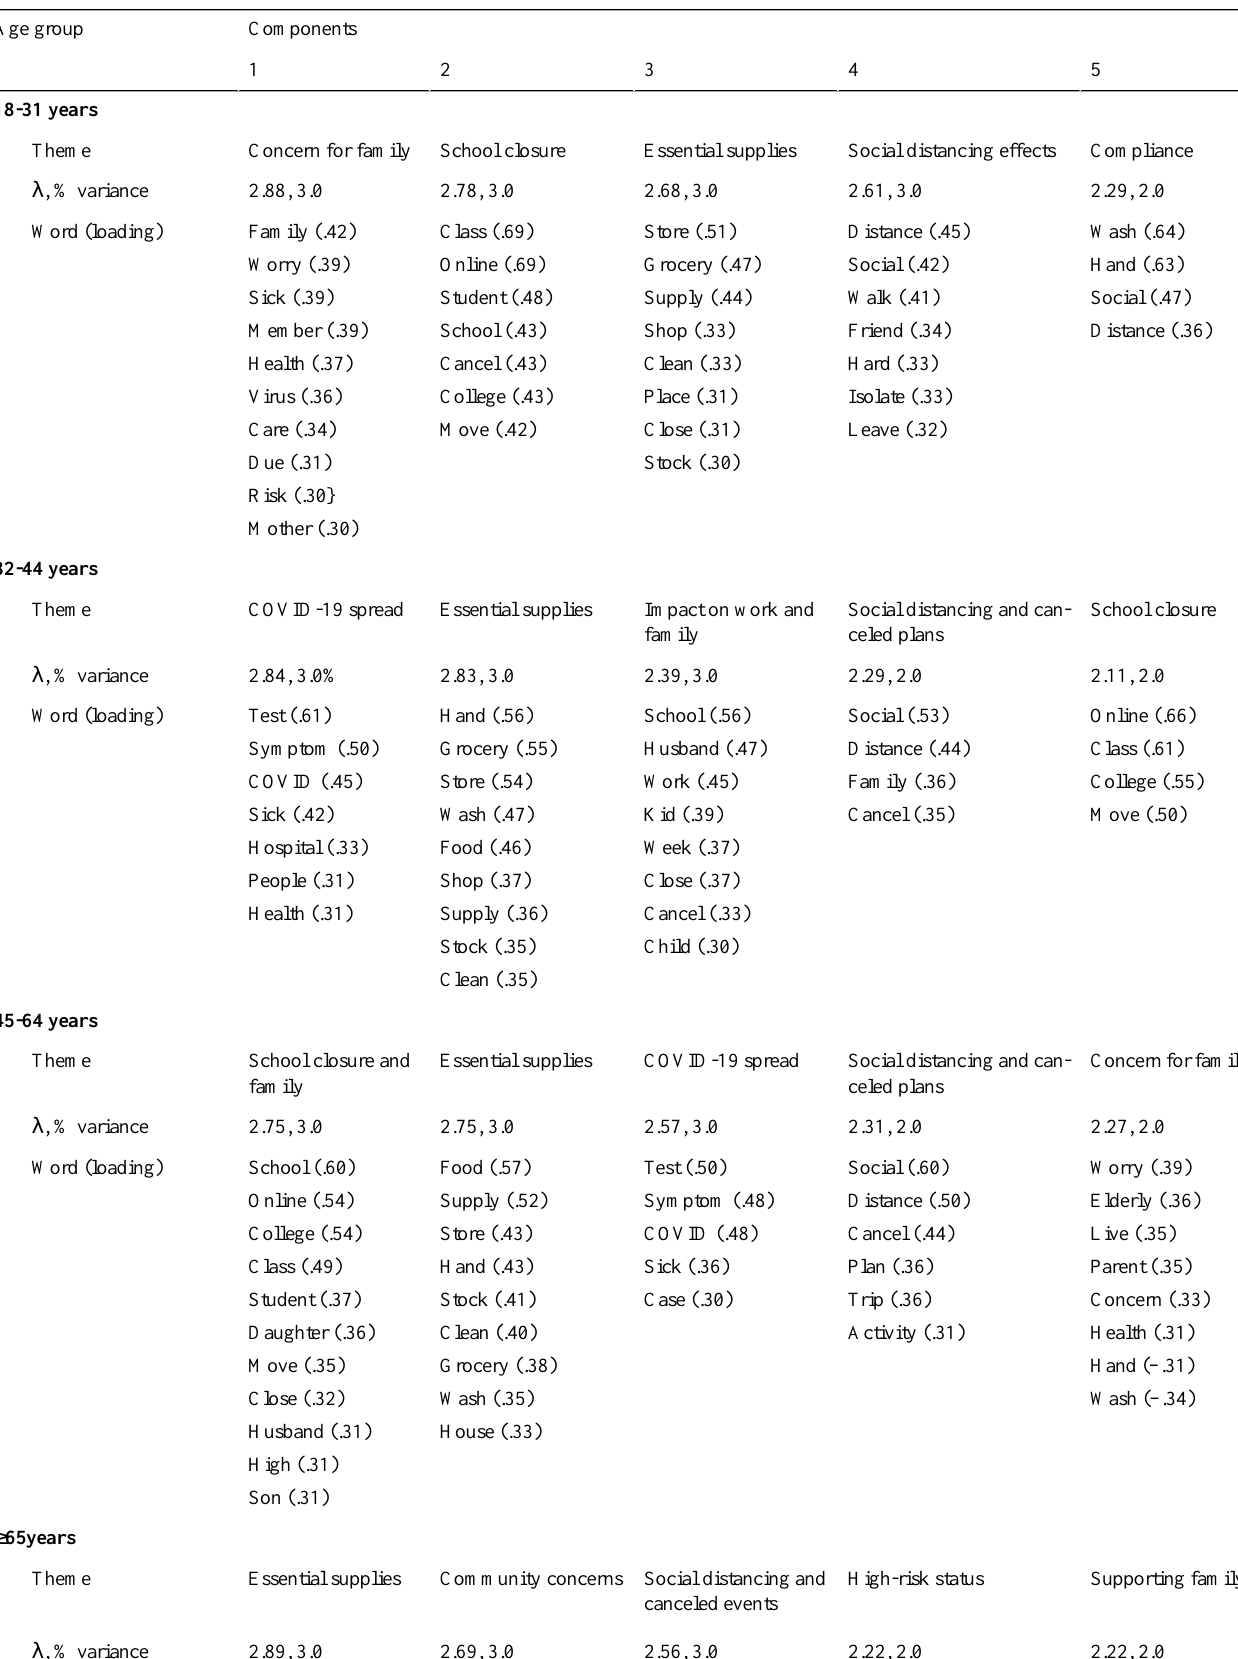
Table 1. Results of the principal component analysis for open-ended responses about the impact of the pandemic by age groups. Note: columns denote component numbers extracted from separate principal component analyses for each age group, subjected to Varimax rotations. Words were selected for inclusion on the component if their loading was greater than or equal to